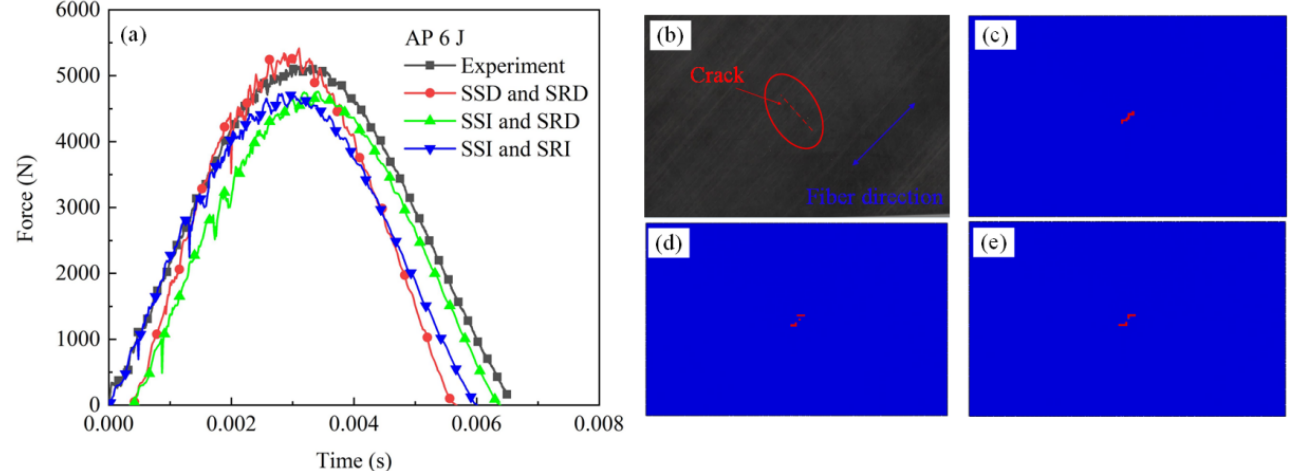
Figure 8. Comparison of experimental results and simulation results ( a ) contact force; ( b ) experimental failure pattern; ( c ) SSD and SRD ( d ) SSI and SRD ( e ) SSI and SRI simulation result. Table 3. Maximum contact force comparison of the experimental and numerical